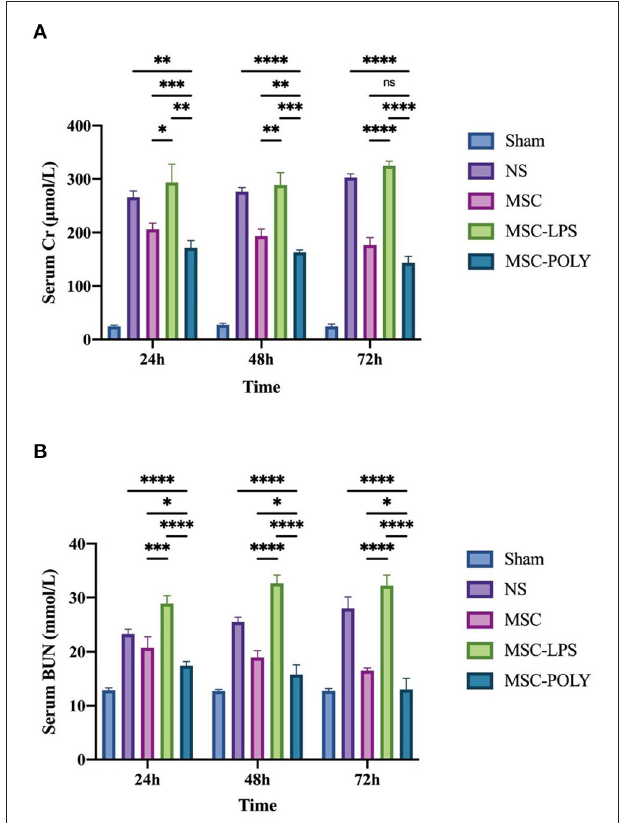
FIGURE 1 | Determination of serum creatinine and blood urea nitrogen contents. (A) Serum creatinine contents of mice at three time points after sham operation (Sham), treatment with normal saline (NS), untreated mesenchymal stem cells (MSC), mesenchymal stem cells treated with 10 µ g/mL LPS (MSC-LPS), and mesenchymal stem cells treated with 1 mg/mL poly(I:C) (MSC-POLY), respectively. (B) Blood urea nitrogen contents of mice at three time points of five groups. Values were expressed as mean ± standard deviation (mean ± SD), n = 6, ns = not statistically significant, * P < 0.05, ** P < 0.01, *** P < 0.001, **** P <